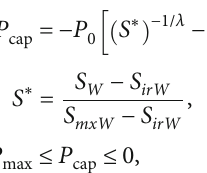
on the 10 th day, 365 th day, 1825 th day, and 3650 th day in the case with S G